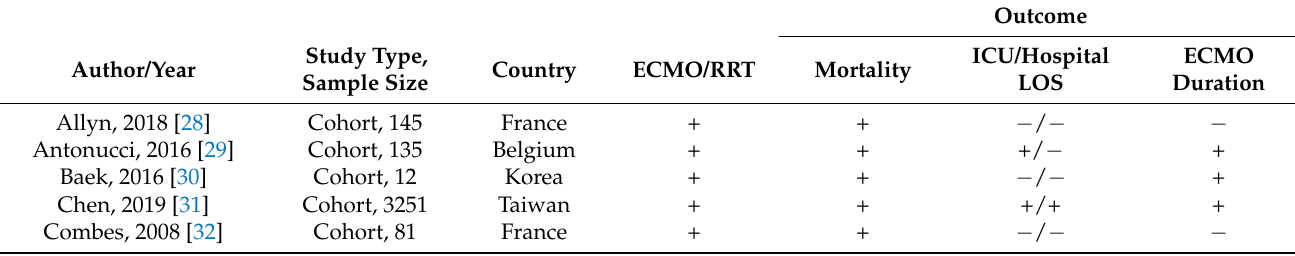
Table 1. Summary of all